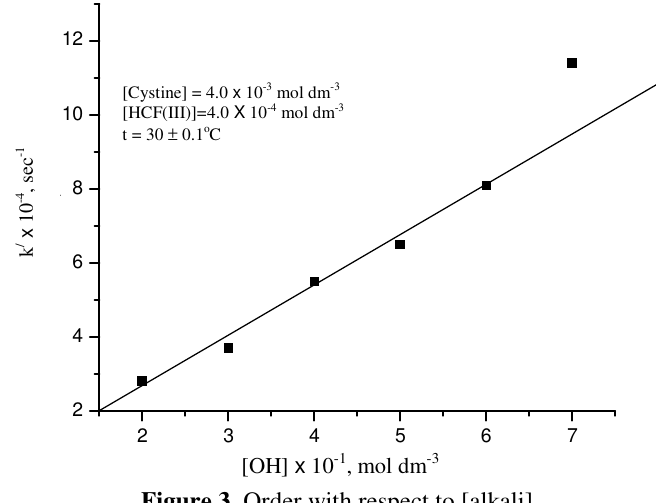
Figure 3. Order with respect to